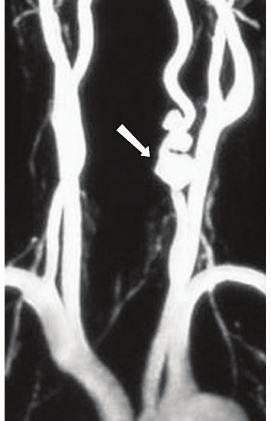
Figure 1: CT 3D reconstruction of the cervical spine shows erosion of the left intravertebral C6-C7 foramen (arrow).